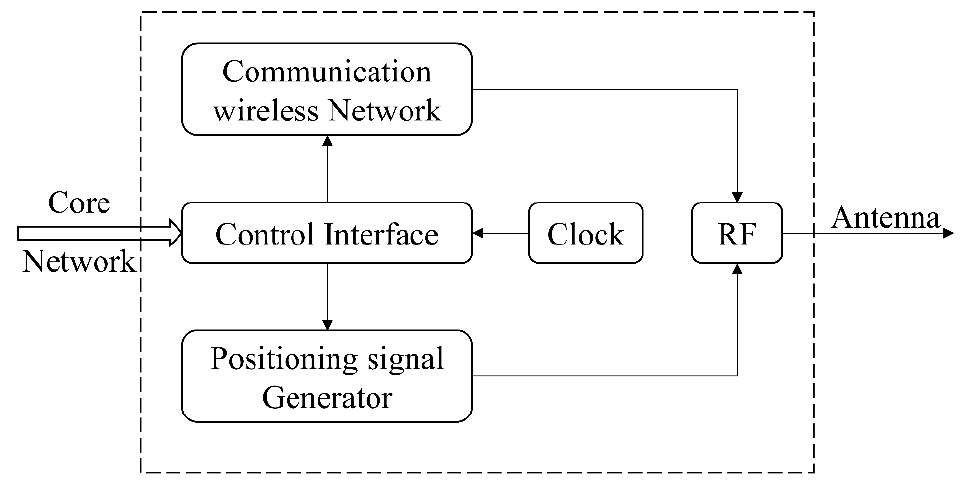
Figure 1. Structure of the CPIS base station.